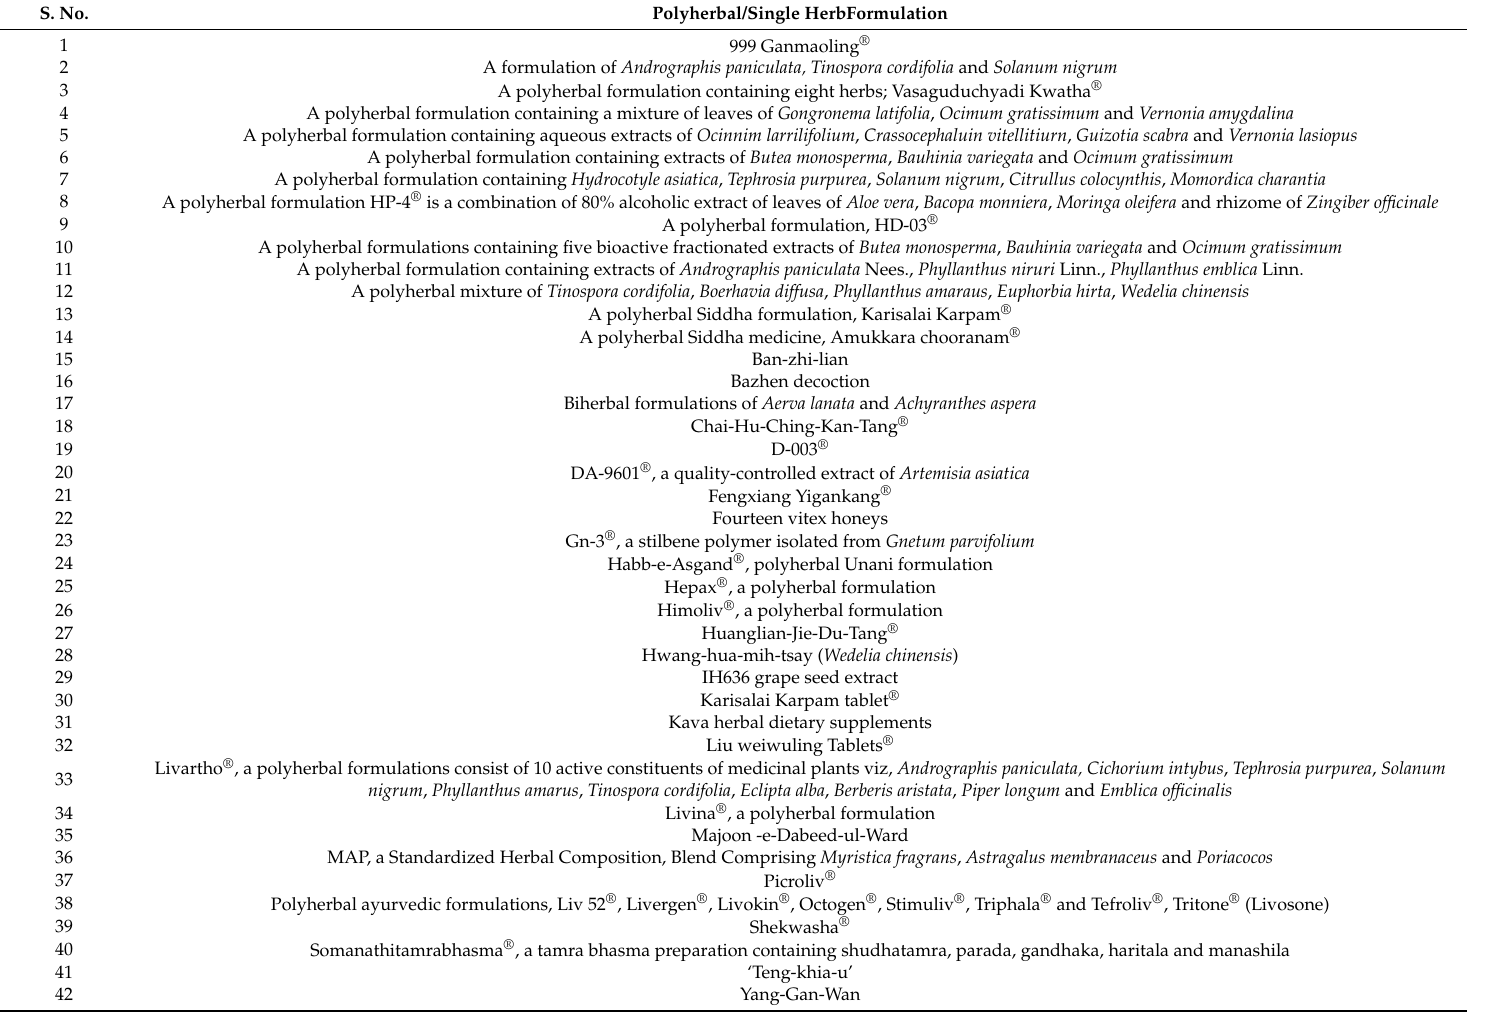
Table 5. The polyherbal or single herb formulations showed protective against APAP-induced liver toxicity. S.